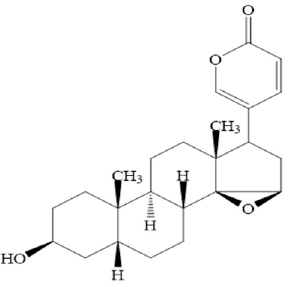
Figure 1. The chemical structures of resibufogenin (RBG).